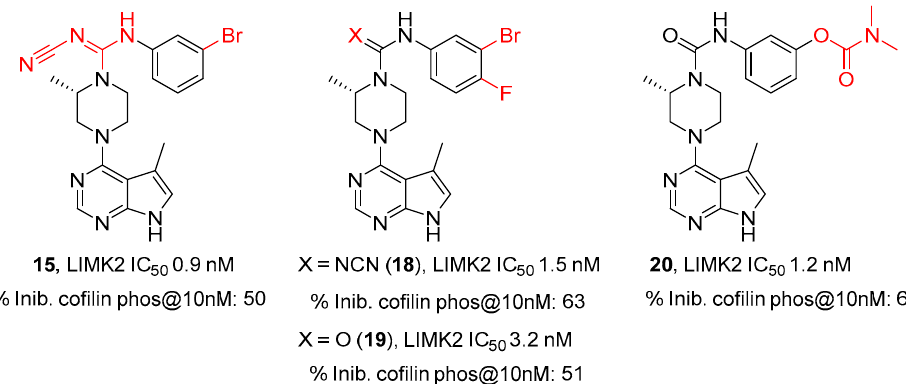
Figure 4. Lead LIMK2 inhibitors, Lexicon Pharmaceuticals 2009.